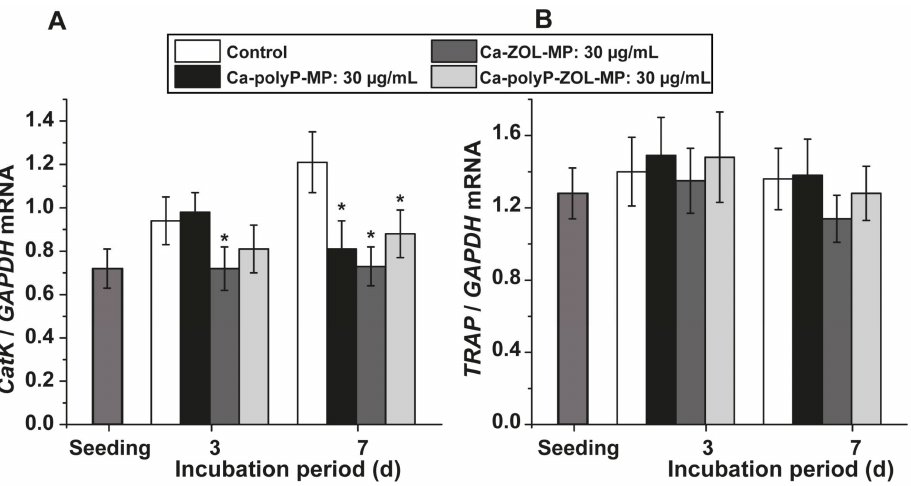
Figure 7. Alteration of the expression in bone marrow cells using ( A ) the established osteoclastic differentiation marker cathepsin-K and ( B ) the level of TRAP , which reflects both the osteogenic and the osteo-clastogenic proliferation state of the cells; * p <